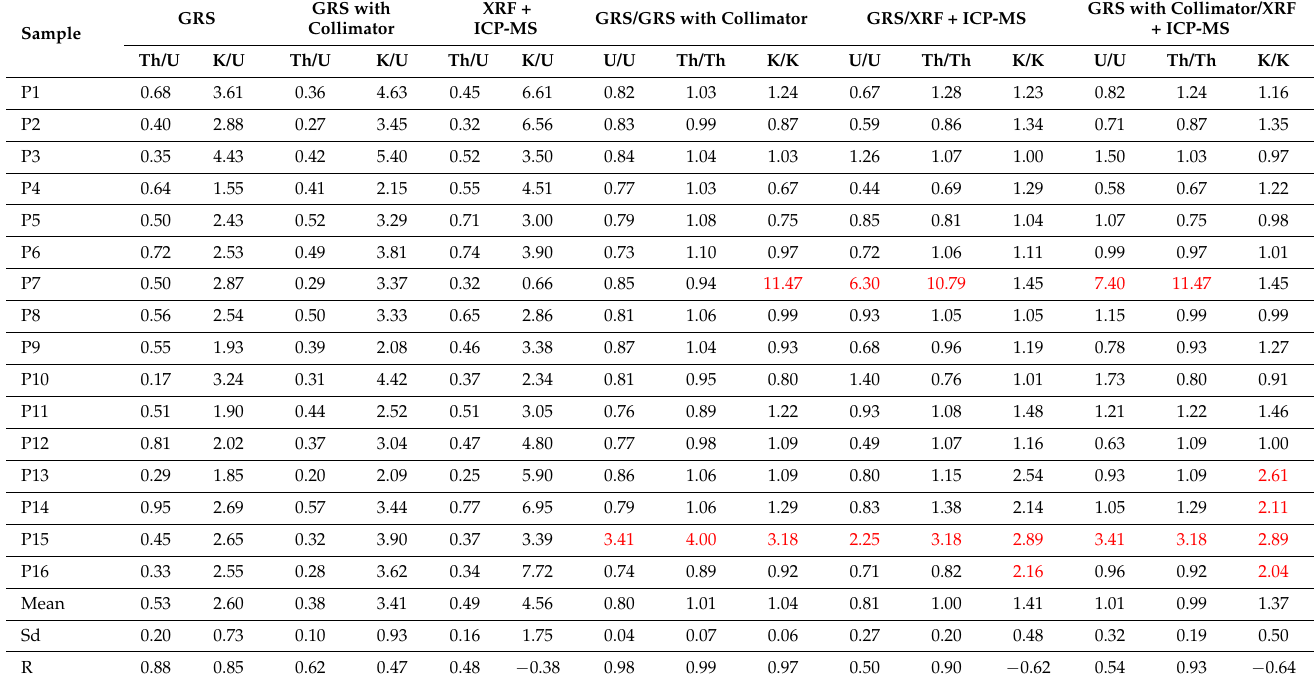
Table 4. Estimated ratios of Th/U and K/U for the geochemical analyses and GRS measurements. U, Th, and K ratios obtained by geochemical analyses and the two different GRS measurements are also provided. Outliers are marked in